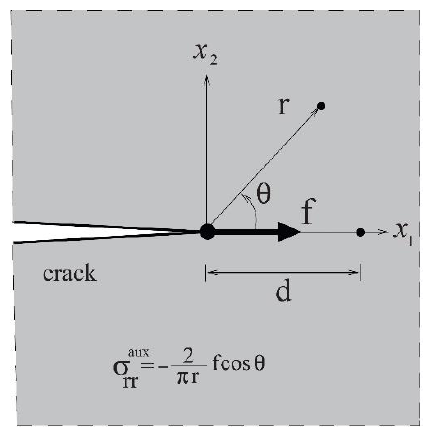
Figure 3. Local coordinates and point force f for T-stress